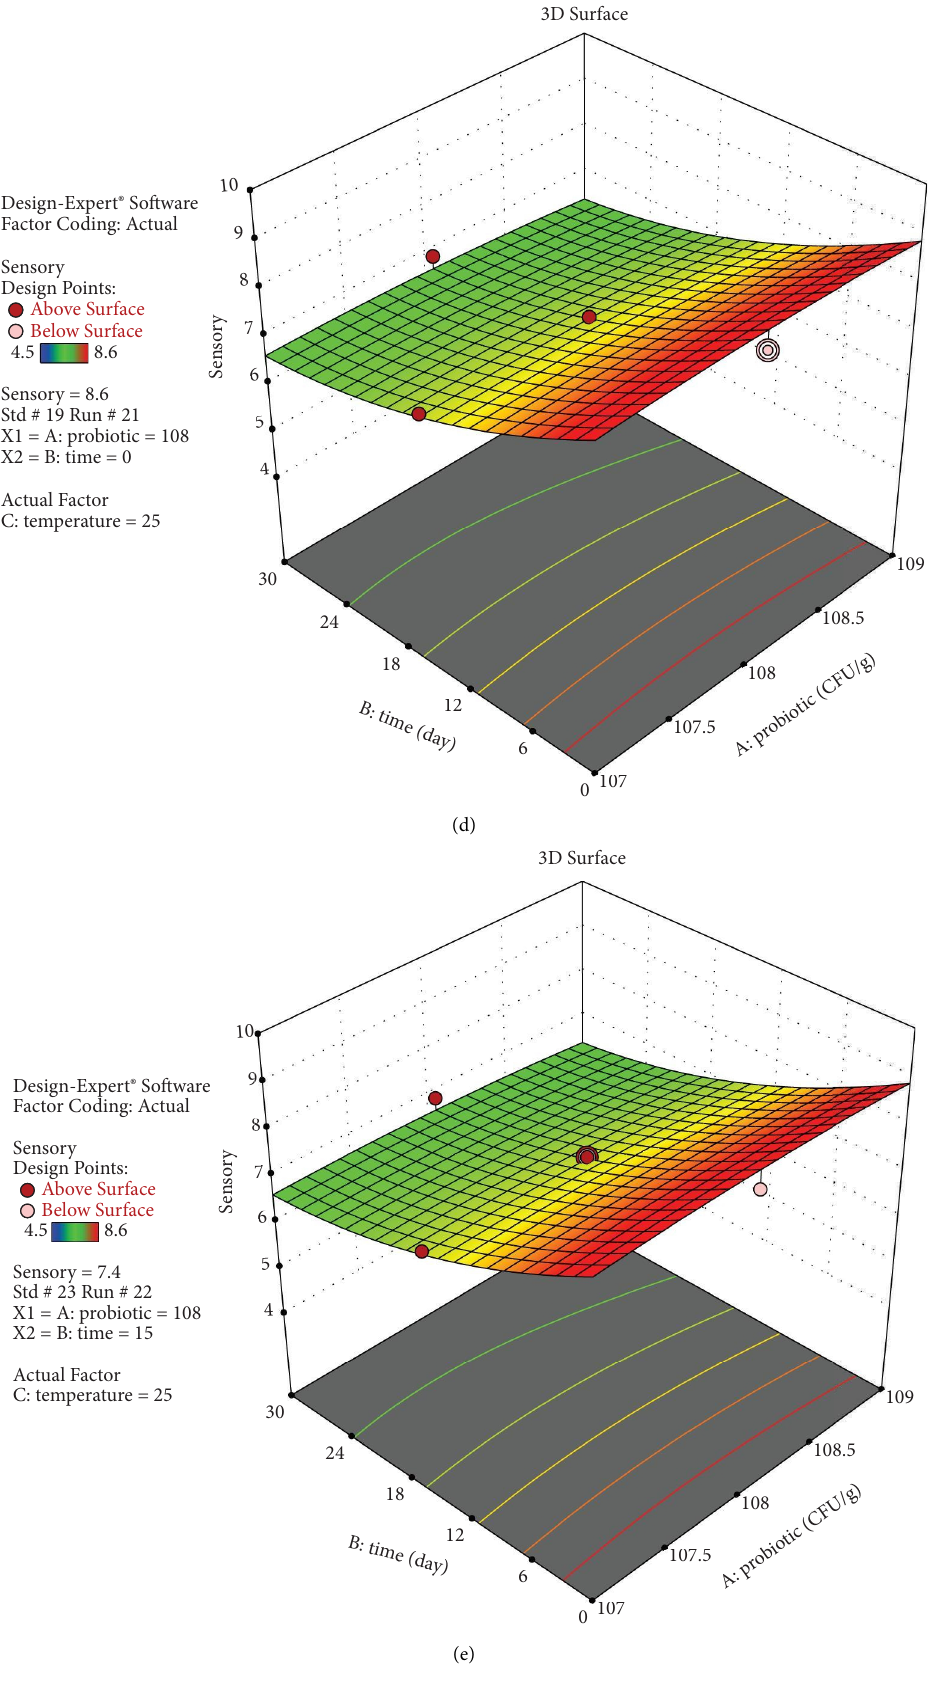
Figure 7: Te efect of storage temperature (25 ° C) on the overall acceptance of pistachio